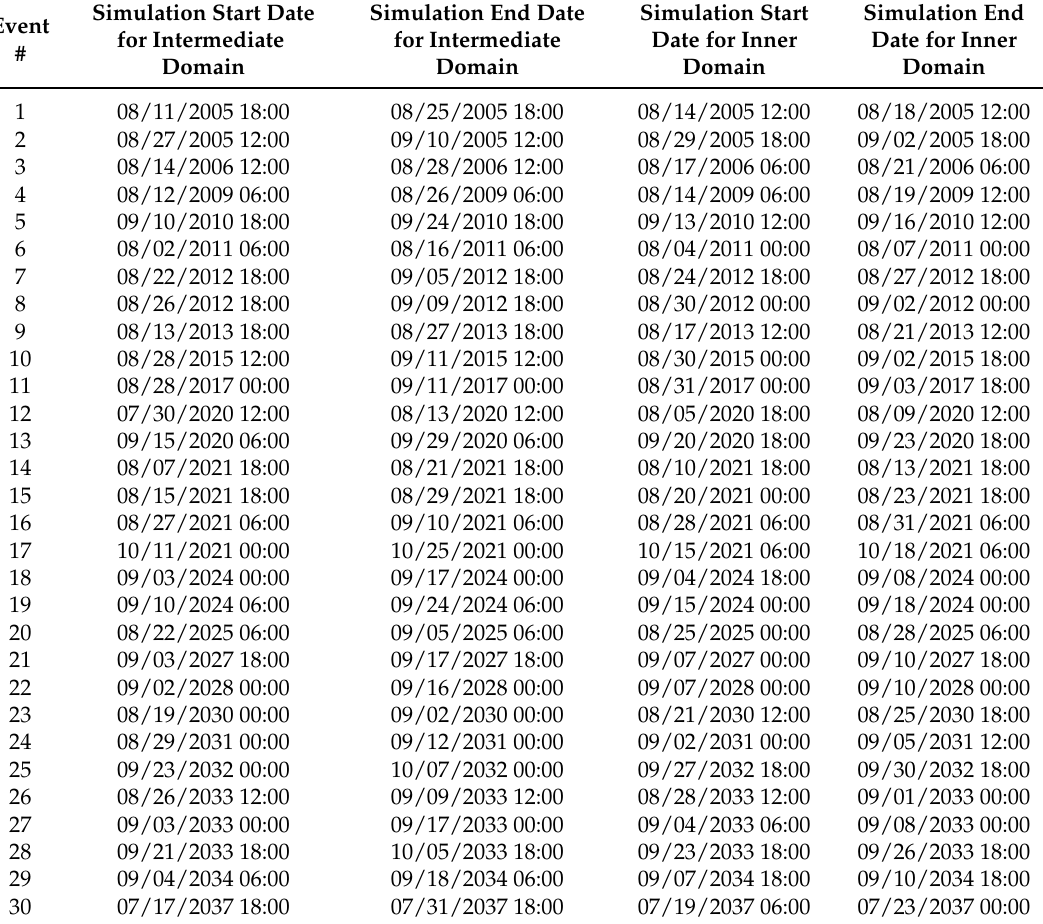
Table A1. Start dates and end dates for the simulation in the intermediate and inner domains of the 64 landfalling TCs. Coordinated Universal Time (UTC) is